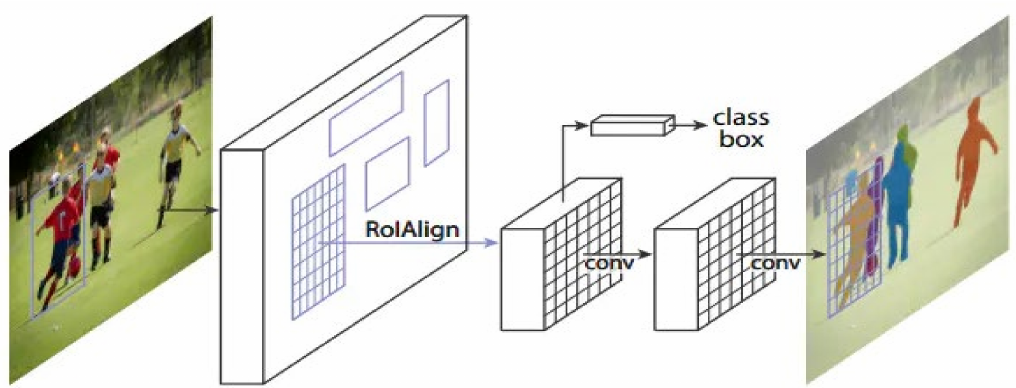
Figure 13. The Mask R-CNN